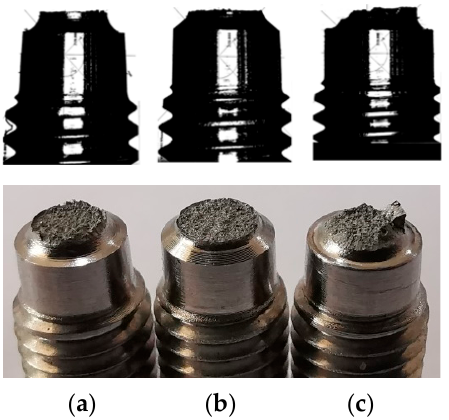
Figure 8. Simulated fracture appearances. ( a ) arc-shaped; ( b ) V-shaped; ( c ) square notch.